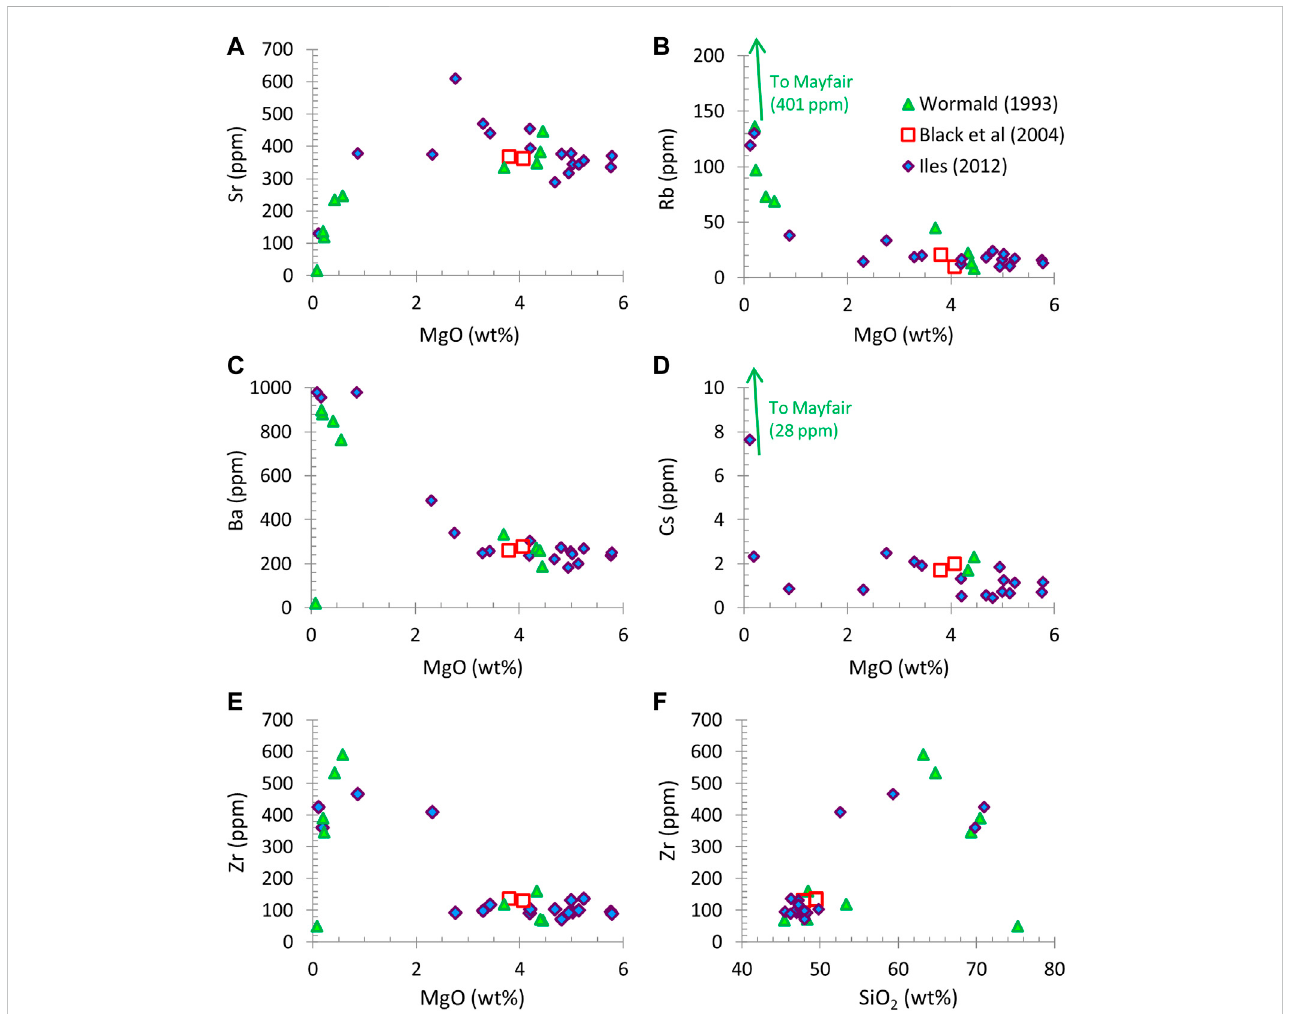
FIGURE 4 Variation diagrams for all Wallundry Suite samples, withtraceelementsplottedagainst MgO (A – E) or SiO 2 (F) (A) Sr displaysa trend similar to CaO. (B and C) Rb and Ba show the least scatter, and have trends similar to K 2 O. (D) Cs is the most scattered of the LILEs and its trend is similar to that of Rb, but enrichment occurs only in one sample (WQM). (E and F) Zr concentration plotted against MgO and SiO 2 respectively. Plotting against MgO shows the uniformity of Zr for a range of ma fi c compositions (all bar one of the MGD samples). Plotting against SiO 2 and including the data of Wormald (1993) and Black et al. (2004) shows the detail of the variation of Zr in the more felsic samples of the Wallundry